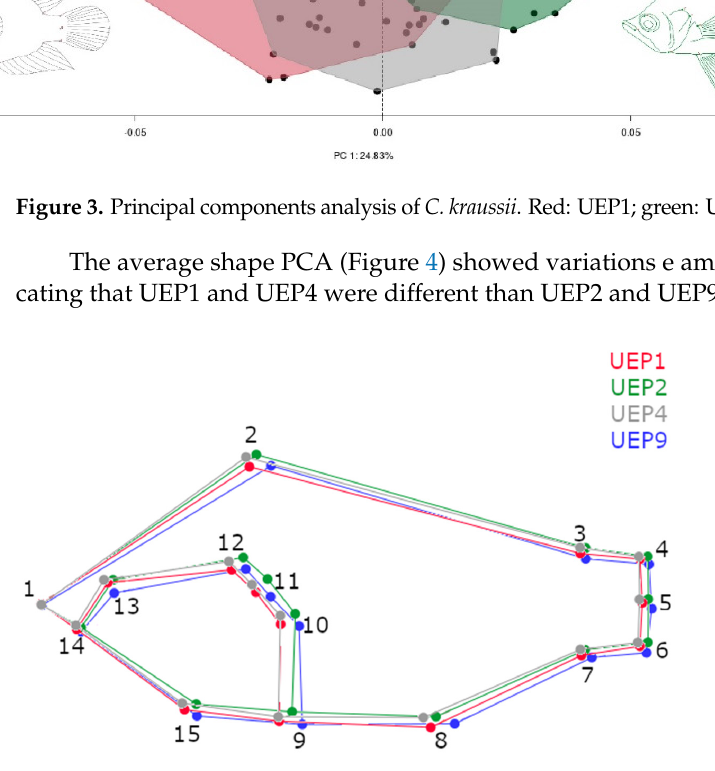
Figure 4. Graphic representation of variation in the mean shape of C. kraussii of the populations and their reference points. Red: UEP1; green: UEP2; grey: UEP4; blue: UEP9. The variations in UEP1 and UEP4 have a conserved and compact shape, but with small variations. UEP1 shows a lowering of points 2 and 8, which represent the first dorsal and anal fins, respectively, with respect to UEP4. UEP2 and UEP9 have differences in shape compared to the other populations, with a more elongated shape; landmarks 4, 5, 6, 10, 11 and 12 (dorsal insertion of caudal fin, ventral insertion of caudal fin, central in- sertion of caudal fin, insertion of pectoral fin, posterior border of the operculum and dor- sal border of the preoperculum, respectively), show longitudinal displacement towards the caudal part of the fish. In UEP9, landmarks 7 and 8 (posterior insertion of anal fin and first anal spine) are lower than in the other three populations. UEP2 have narrower bodies, more flattened ventral area and more erect caudal area than UEP1, UEP4 and UEP9. The multivariate regression of size on shape (Figure 5) showed that the allometric effect was only 2.73%; individuals of UEP2 were smaller than the other localities and UEP1 and UEP4 were the largest; those of UEP9 were intermediate in size. Figure 5. Multivariate regression between body shape and centroid size of C. kraussii. Colors repre- sent localities: red: UEP1; green: UEP2; grey: UEP4; blue: UEP9.